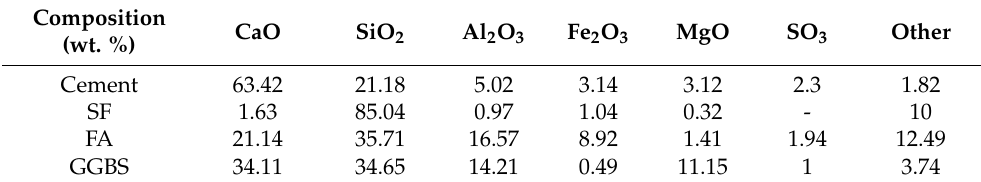
Table 1. Chemical composition of binders [29].